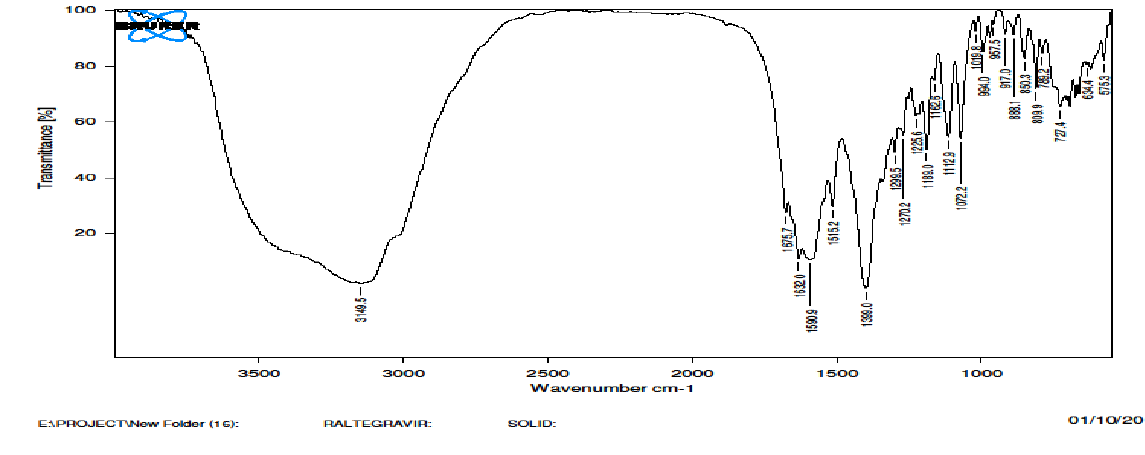
Figure 4. FTIR spectra of raltegravir